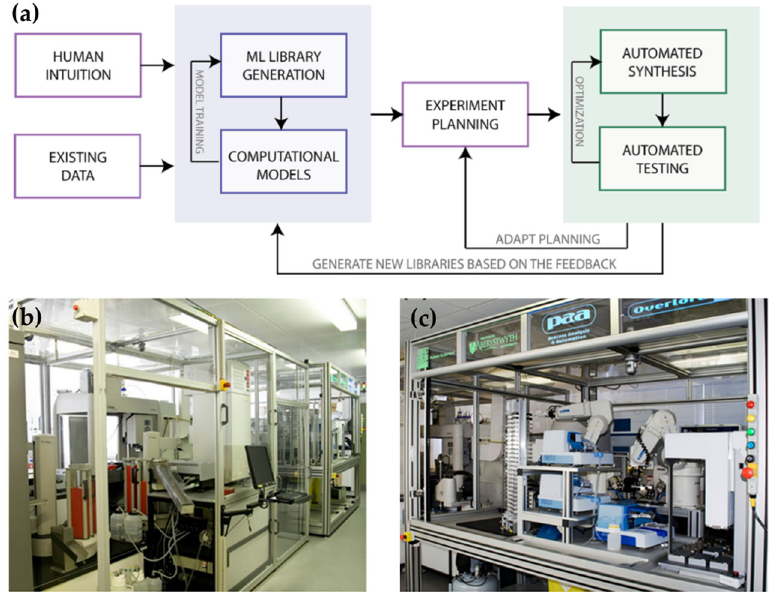
Figure 3. Unmanned chemical system. ( a ) Schematic illustration of an autonomous discovery system; ( b ) Adam’s laboratory robotic system; ( c ) Eve’s laboratory robotic system. Figure 3a is reprinded with permission from Ref. [25]. Copyright 2019, American Chemical Society. Figures 3b and 3c are adapted from Ref. [27] and used under CC BY 2.0.